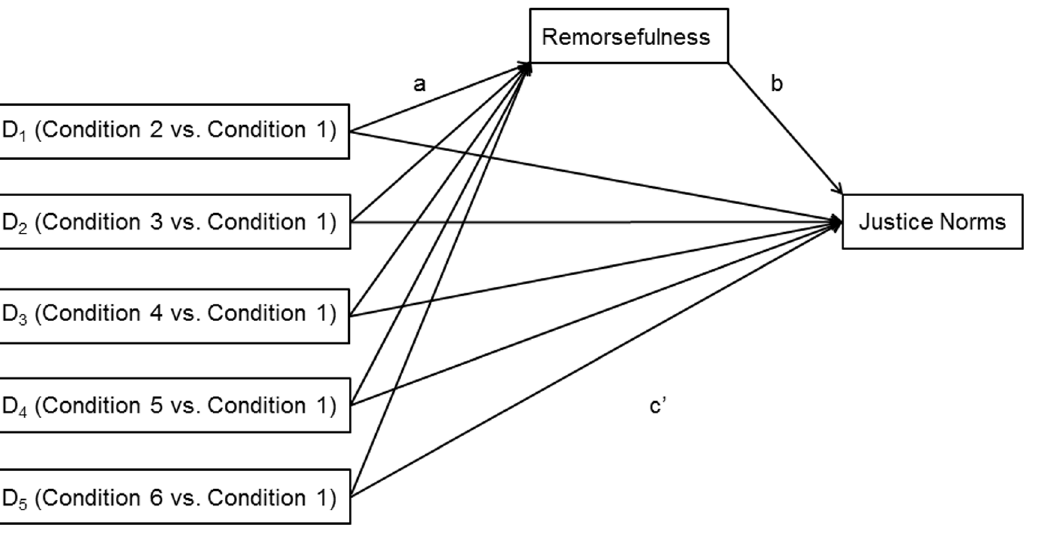
Figure 1. Mediation model of each apology by perceived remorsefulness on justice